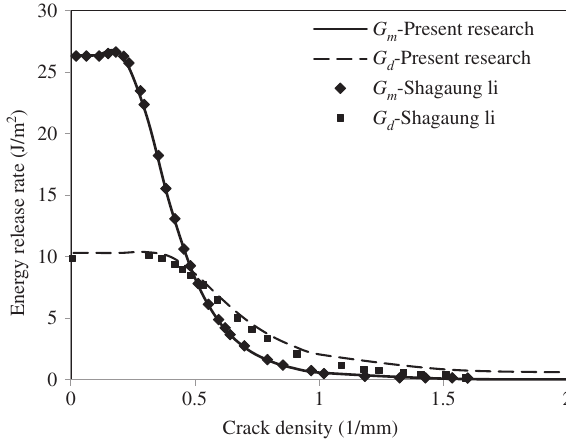
Figure 5: Comparison of the obtained energy release rate with Li’s